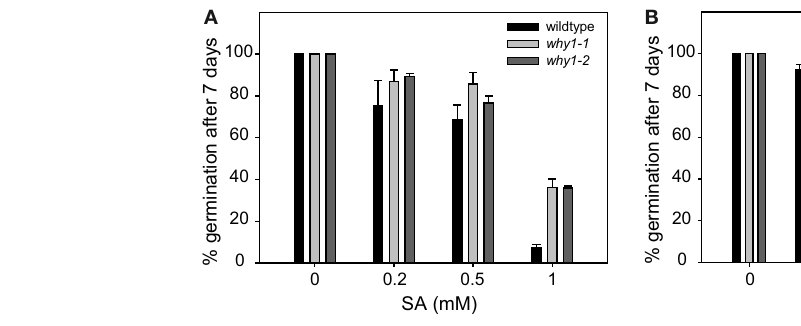
either SA or ABA, respectively, the percentage of seeds showing radicle emergence was scored after 7days of growth at 21˚C in a 16-h light/dark regime.Values are the means ± SEM obtained from at least three independent experiments with 20–50 seeds each.The averaged percentage of germinated seeds in the control experiments without SA and ABA, respectively, was set to 100% and used as a reference to calculate the percentage of germination in the assays performed in the presence of SA or